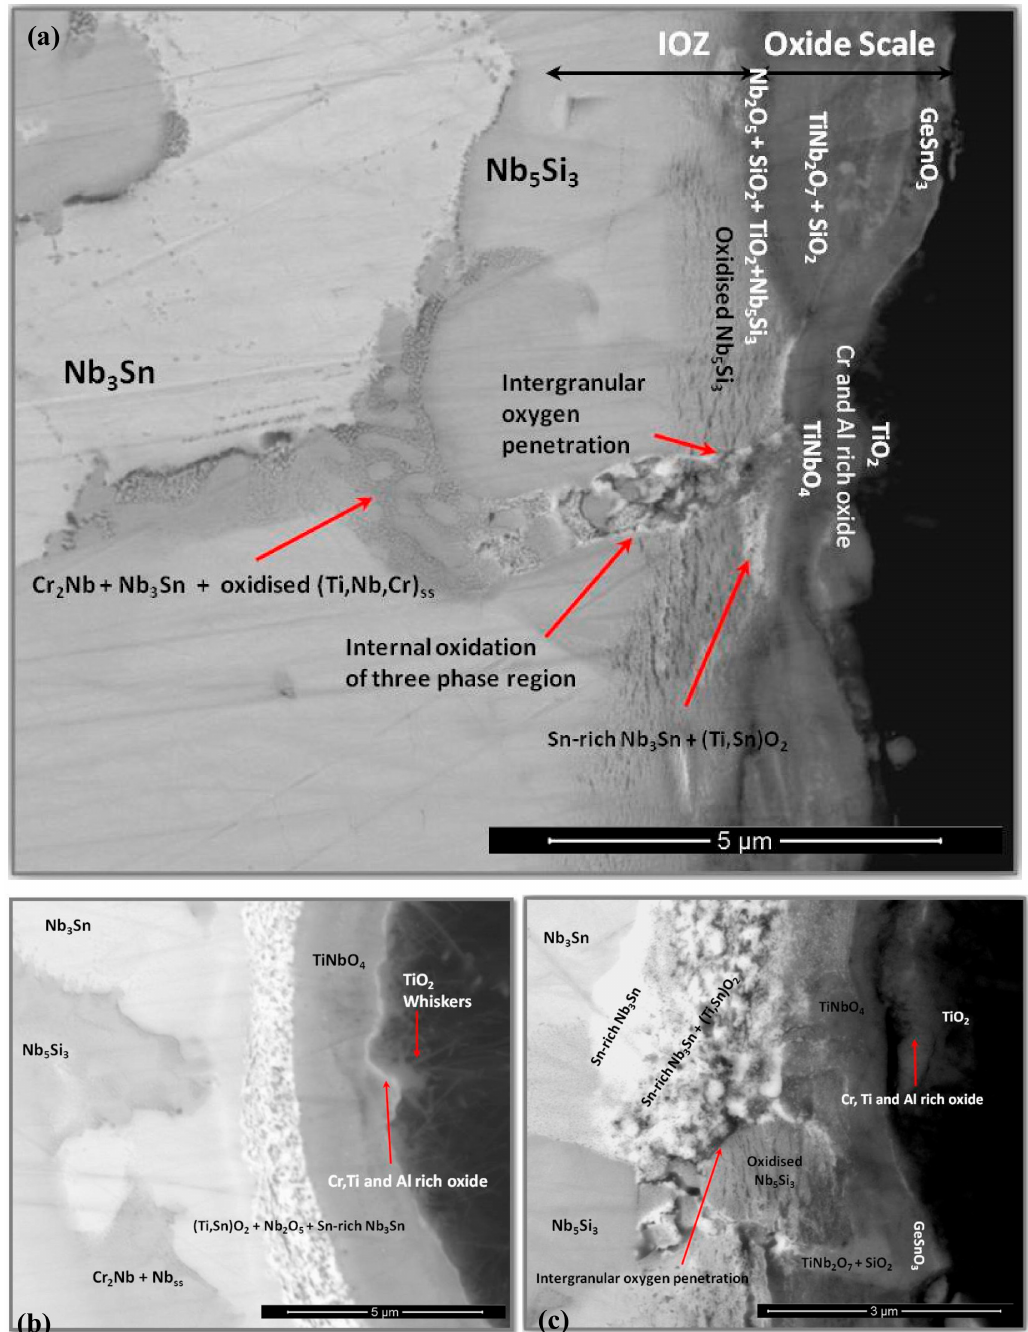
Figure 8. BSE images of a cross section of the alloy OHS1 after isothermal oxidation at 800 ◦ C showing the microstructure ( a ) of the substrate and scale, ( b ) of the scale formed on top of the Nb 3 Sn phase, and ( c ) of the three-phase region after